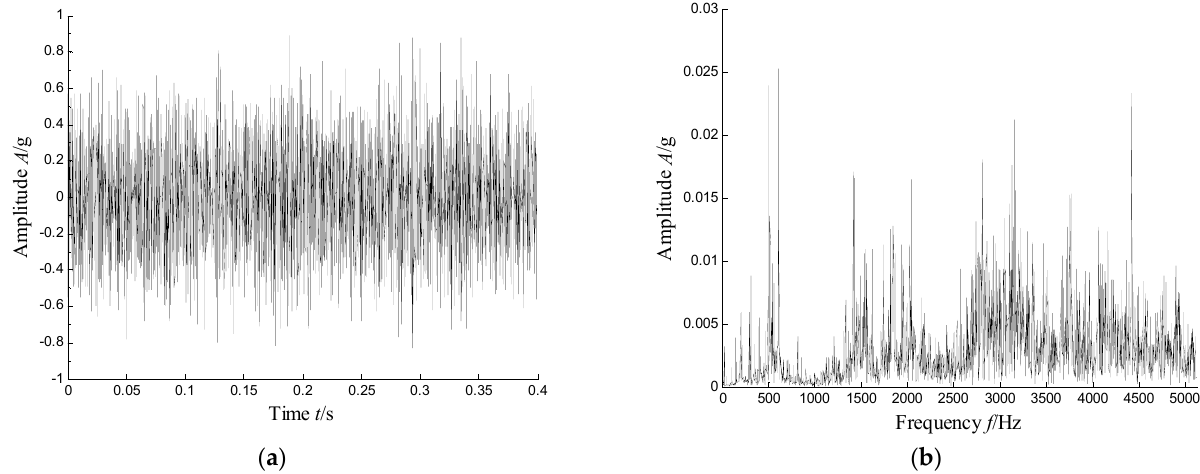
Figure 27. Waveform and spectrum of the vibration signal with an inner race fault bearing: ( a ) waveform and ( b ) spectrum.